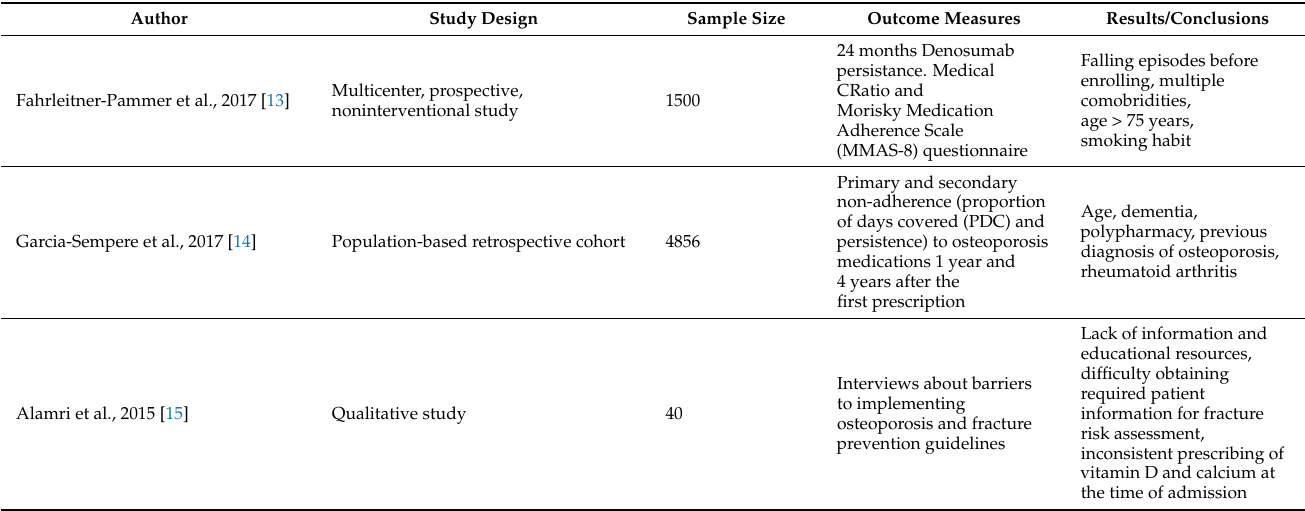
Characteristics of studies analyzing factors and barriers influencing adherence and